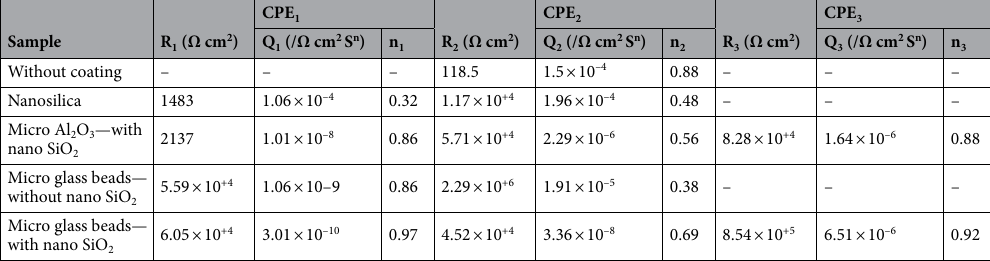
cant increase in corrosion resistance, it can be concluded that most of these pores have not reached the surface and the superhydrophobic properties have improved corrosion resistance. The quantitative parameters of the electrical equivalent circuits for PTFE coatings were calculated by fitting experimental impedance spectra using EEC with three R–CPE circuits (Fig. 8d). In this circuit, the parameters of R 1 , CPE 1 , R 2 and CPE 2 are coating layer resistance, non-ideal coating capacity, corrosion polarization resistance, and non-ideal capacity of the double layer of electrolyte on the metal surface, respectively. The emergence of a third time constant (R 3 -CPE 3 ) could be related to better sealing up of pores on the surface of PTFE coating using SiO 2 nanoparticles. Figures 6 and 7 show impedance spectra including experimental data and model fit curves, which simulate the experimental ones with high accuracy. There is a CPE instead of pure capacitance in the presented electrical equivalent circuits. In systems that are inhomogeneous, constant phase quantities are used instead of capacitors 48 . In other words, CPE is used to indicate processes that have some dissipative properties in addition to memory properties (such as capacitors whose charge and discharge in them is memory processes) 49 . The CPE impedance value is defined by two parameters n and Q , and its value is calculated using Eq. (2).